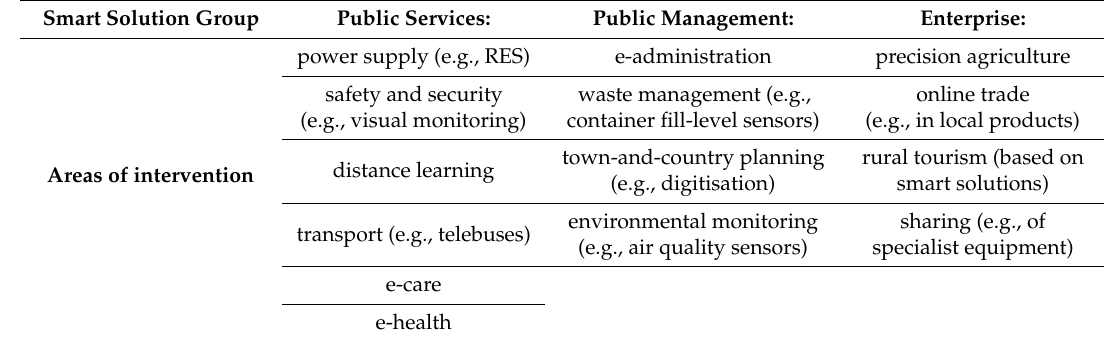
Table 1. Examples of smart actions in rural